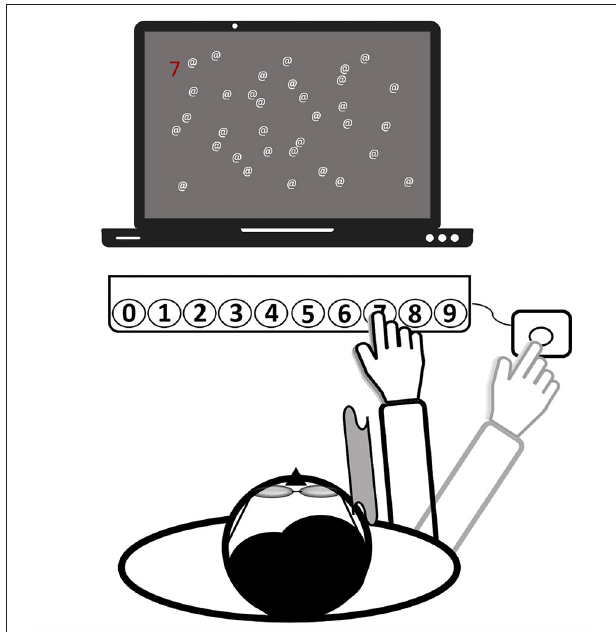
FIGURE 3 | Setup of the prism adaptation treatment (all computerized tasks). Patients wear prism goggles with a cloth attached to their frame (see gray curved area), serving as a visual barrier. The depictured task is to find a randomized number among a few distractors and to press the respective button on the keyboard by making a reaching movement. Finally, for confirming the input, another movement toward an external button (right-hand side) needed to be executed. Then, the hand was laid down at this final position. The task starts